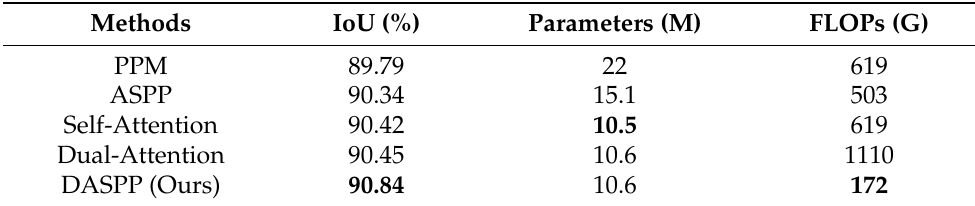
Table 4. Comparison of different multi-scale contest schemes, where the best is in bold. We report the IoU results performed on the WHU dataset. FLOPs are calculated when processing the input with a size of 1 × 2048 × 128 × 128. Note, OHEM and MS are not used for this comparison.